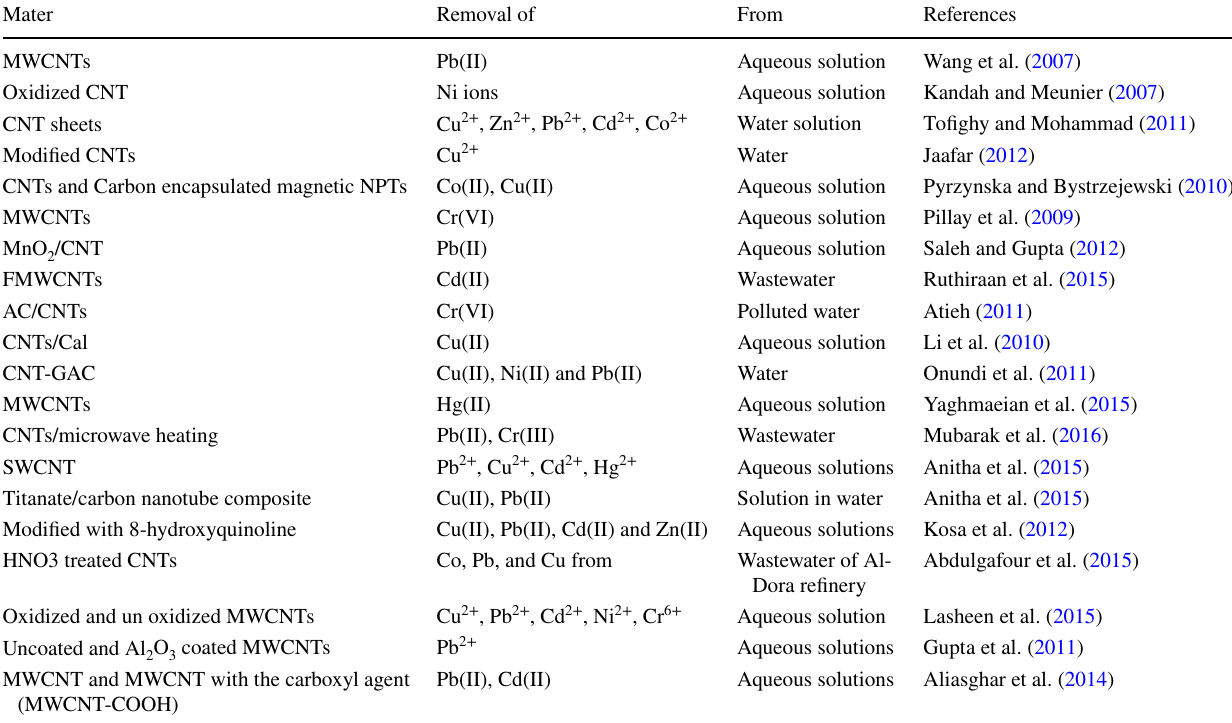
Table 9 Summary of the use of zeolites for water treatment by adsorption Mater Removal of